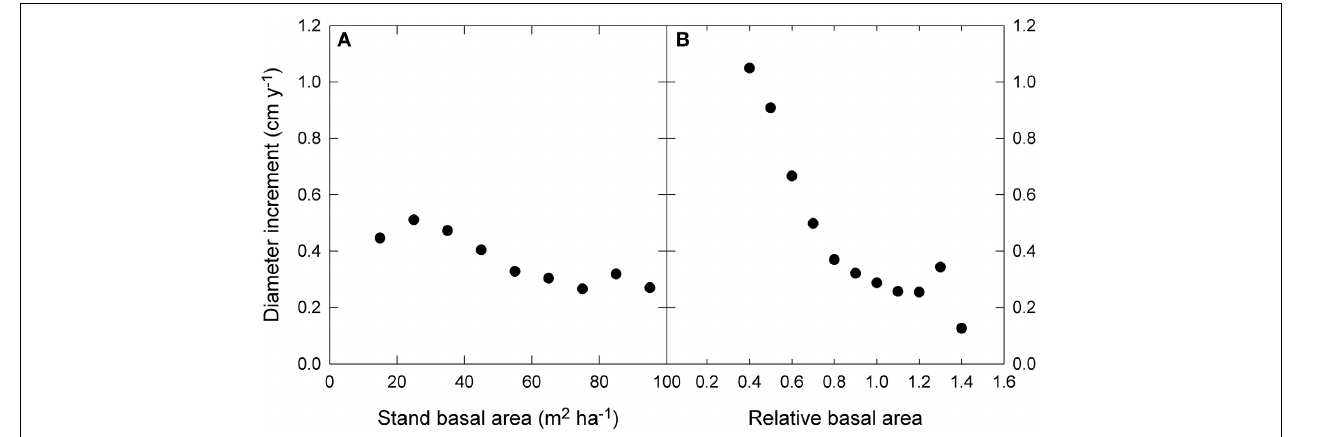
FIGURE 5 | Relationship between diameter growth and (A) stand basal area, and (B) relative basal area. Relative basal area was calculated as square root (stand basal area/the 90th percentile of basal area). The 90th